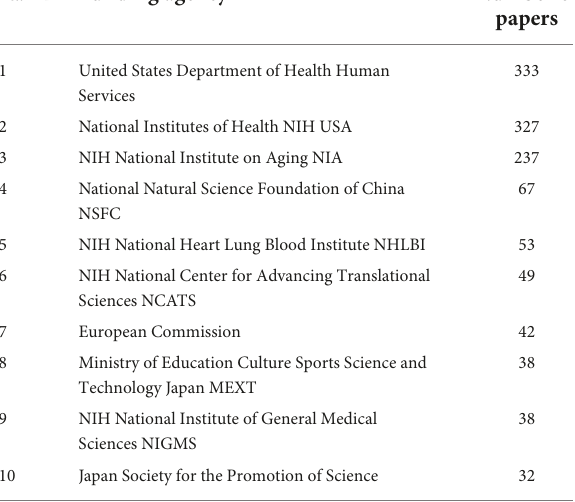
TABLE 5 The top 10 funding agencies with the highest number of publications on postoperative delirium (POD). Rank